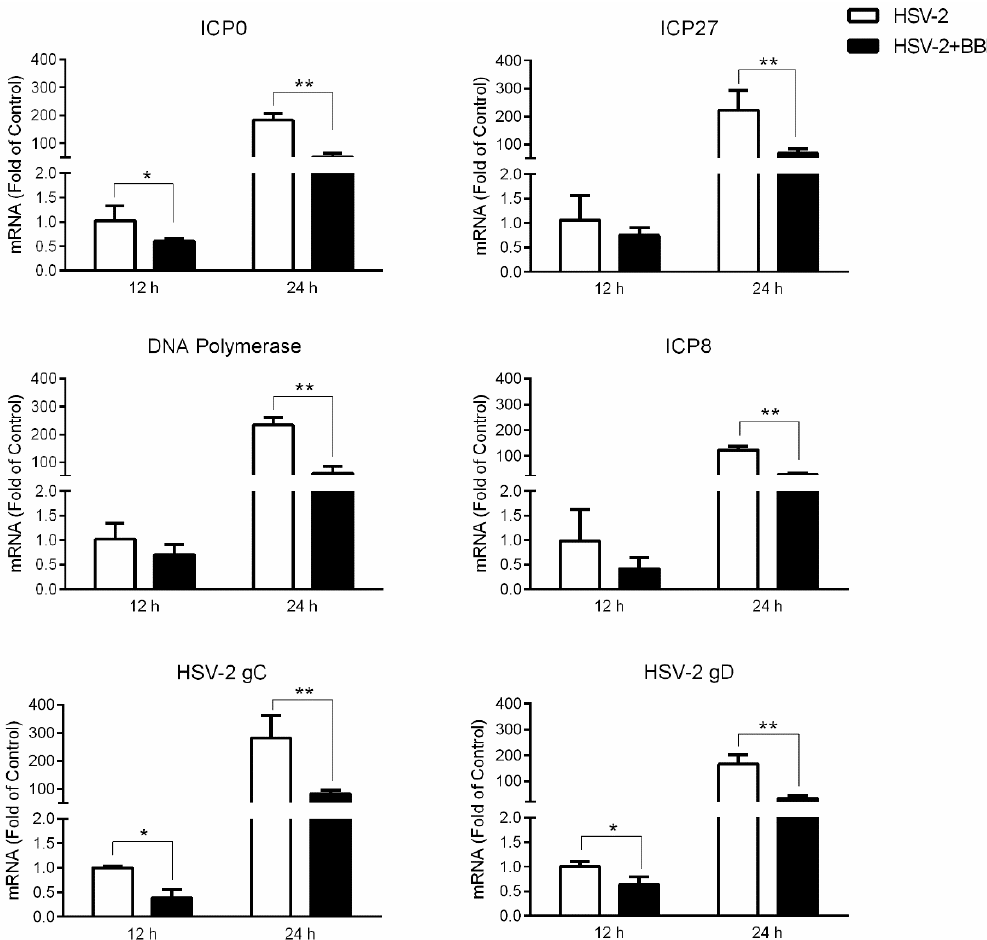
Figure 2. Effect of BBI on HSV-2 gene expression. End1/E6E7 cells were infected with HSV-2 (MOI of 0.002), and then cultured in the presence or absence of BBI (200 µ g/mL). Cellular RNAs were extracted from the virus-infected cells at 12 h or 24 h PI, and the expression of HSV-2 IE , E and L genes were analyzed by the real-time PCR. All results were mean ± SD of triplicate cultures, representative of three independent experiments (* p < 0.05, ** p < 0.01).